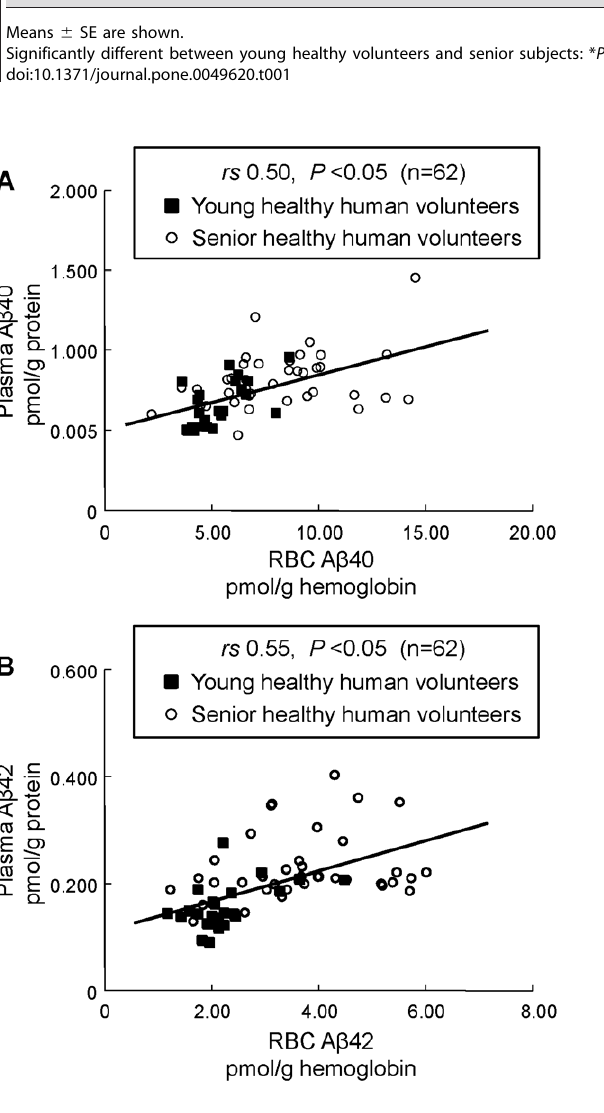
Figure 1. Correlation between RBC and plasma A b 40 (A) or A b 42 (B) concentrations of young healthy human volunteers and senior subjects (N=62). X-axis is the concentration of RBC A b . Y-axis is concentration of plasma A b . PLOS ONE |